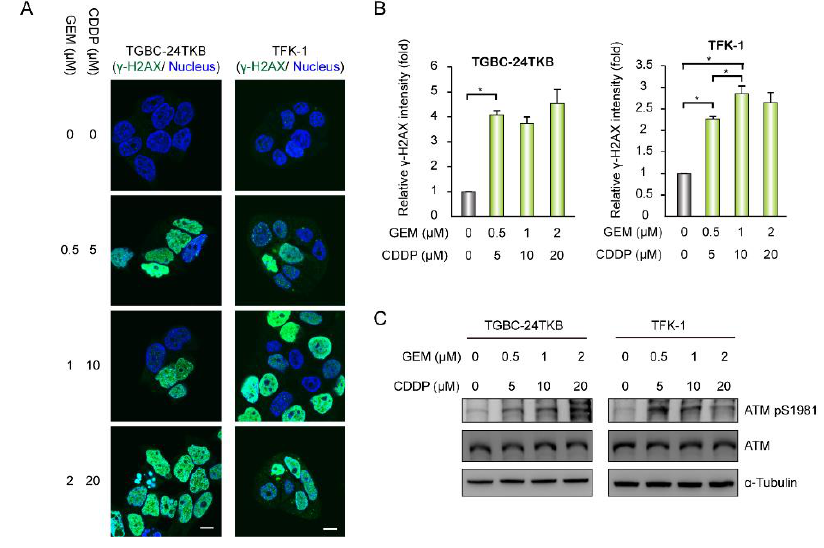
Figure 5. Chemotherapy drugs lead to DNA damage in BTC cells. ( A ) The cells receiving various concentrations of GEM and CDDP for 24 h were fixed and stained with H2AX Ser139 phosphorylation (γ-H2AX) and nuclei. Scale bar = 10 µm. ( B ) The relative fluorescent intensity of γ-H2AX per field was measured ( n = 5) and expressed as the fold change relative to the levels of the cells without chemotherapy drug treatment. The values (means ± SD) are from two independent experiments; * p < 0.05 by Student’s t -test. ( C ) Western blots showing the level of ATM Ser1981 phosphorylation and total ATM in the cells receiving various concentrations of GEM and CDDP for 24 h; α-tubulin was the loading control.